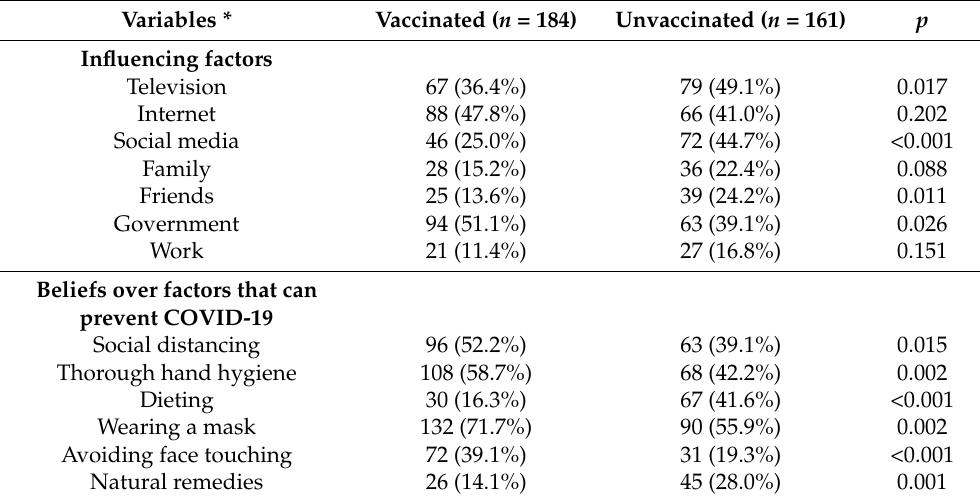
Figure 1. Influencing factors for COVID-19 vaccination.